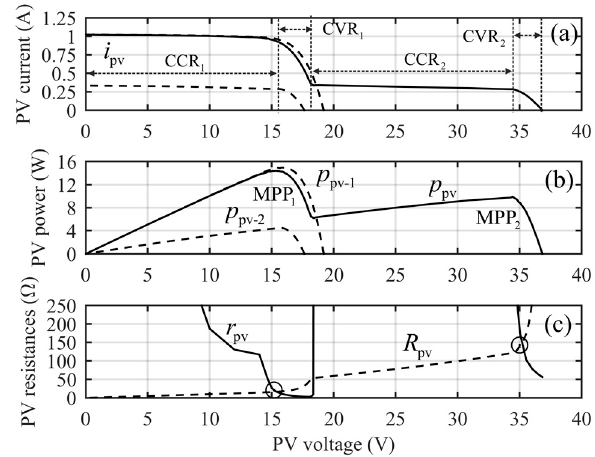
Figure 9. I-V ( a ); P-V ( b ); and r pv / R pv - V ( c ) curves of the series-connected Raloss SR30-36 PV panels with shunt diodes subjected to non-uniform irradiation (( a , b ) solid lines: series connection; dashed line: individual panels; ( c ) solid line: r pv ; dashed line: R pv ; circle: MPPs).